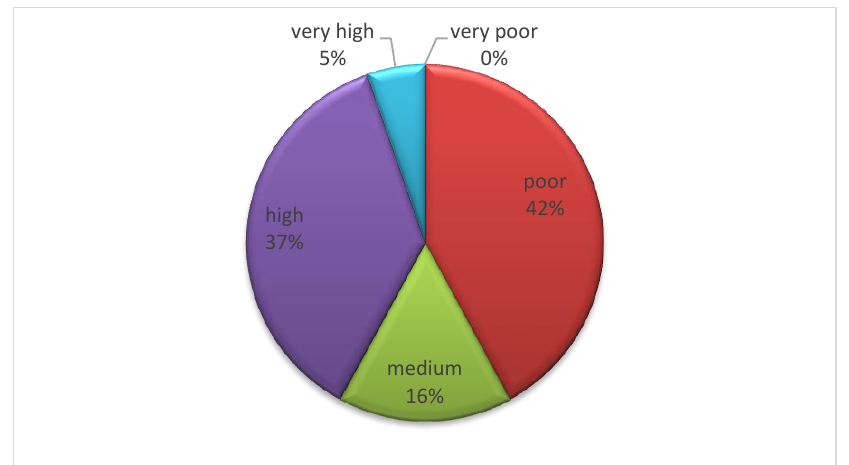
Figure 7. Baitussalam II Students’ HOTS based on Judgment and Critical Thinking Indicator in Percentage